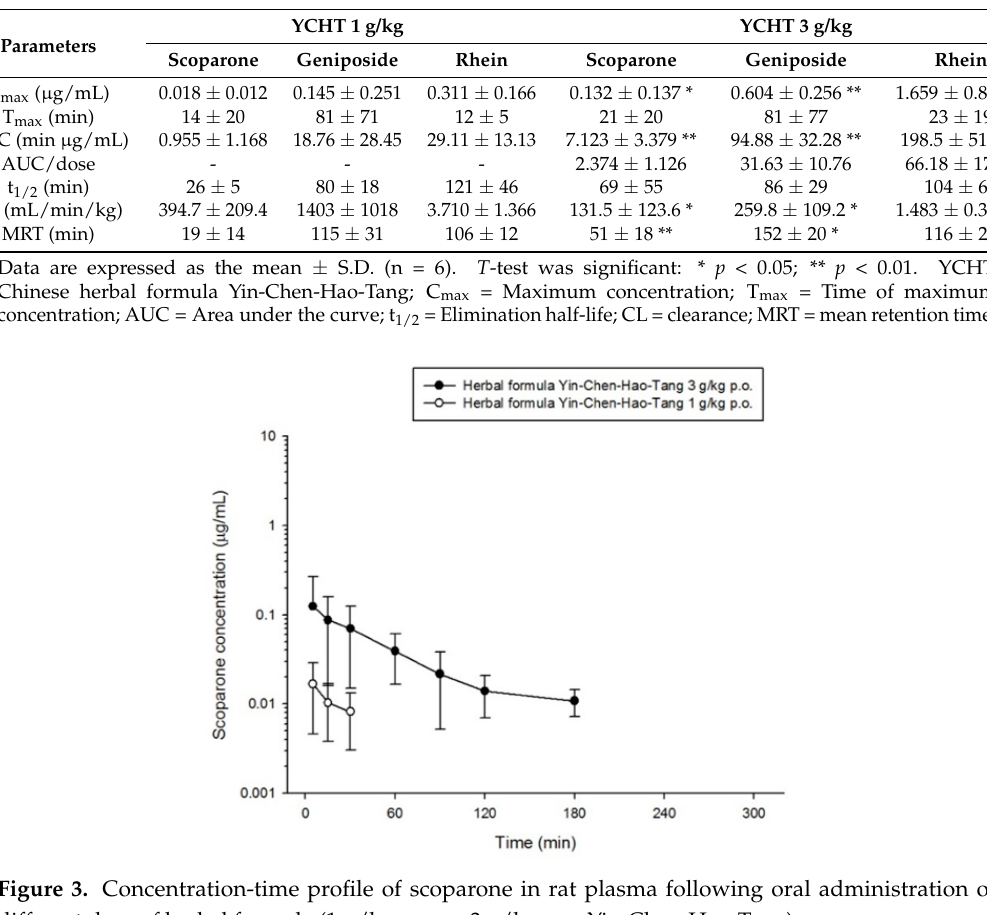
Table 5. Pharmacokinetic parameters of scoparone, geniposide and rhein in rat plasma after administration of the herbal formula Yin-Chen-Hao-Tang.